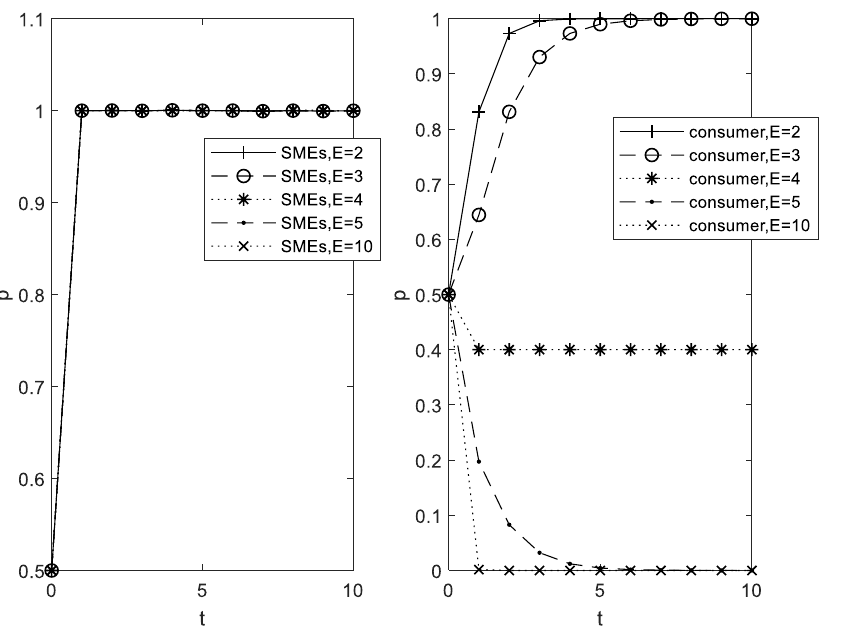
Figure 16. The additional purchasing expenditure E for SMEs who give positive reviews on system evolution.